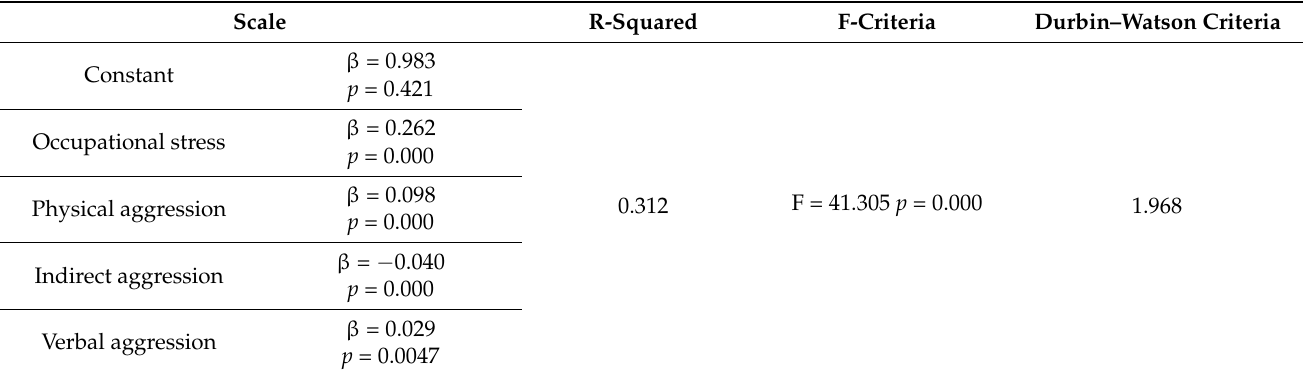
Table 11. Assessment of the contribution of occupational stress and aggression (physical, indirect, and verbal) to the development of depersonalization in COVID-19 ICU HCWs. Scale R-Squared F-Criteria Durbin–Watson